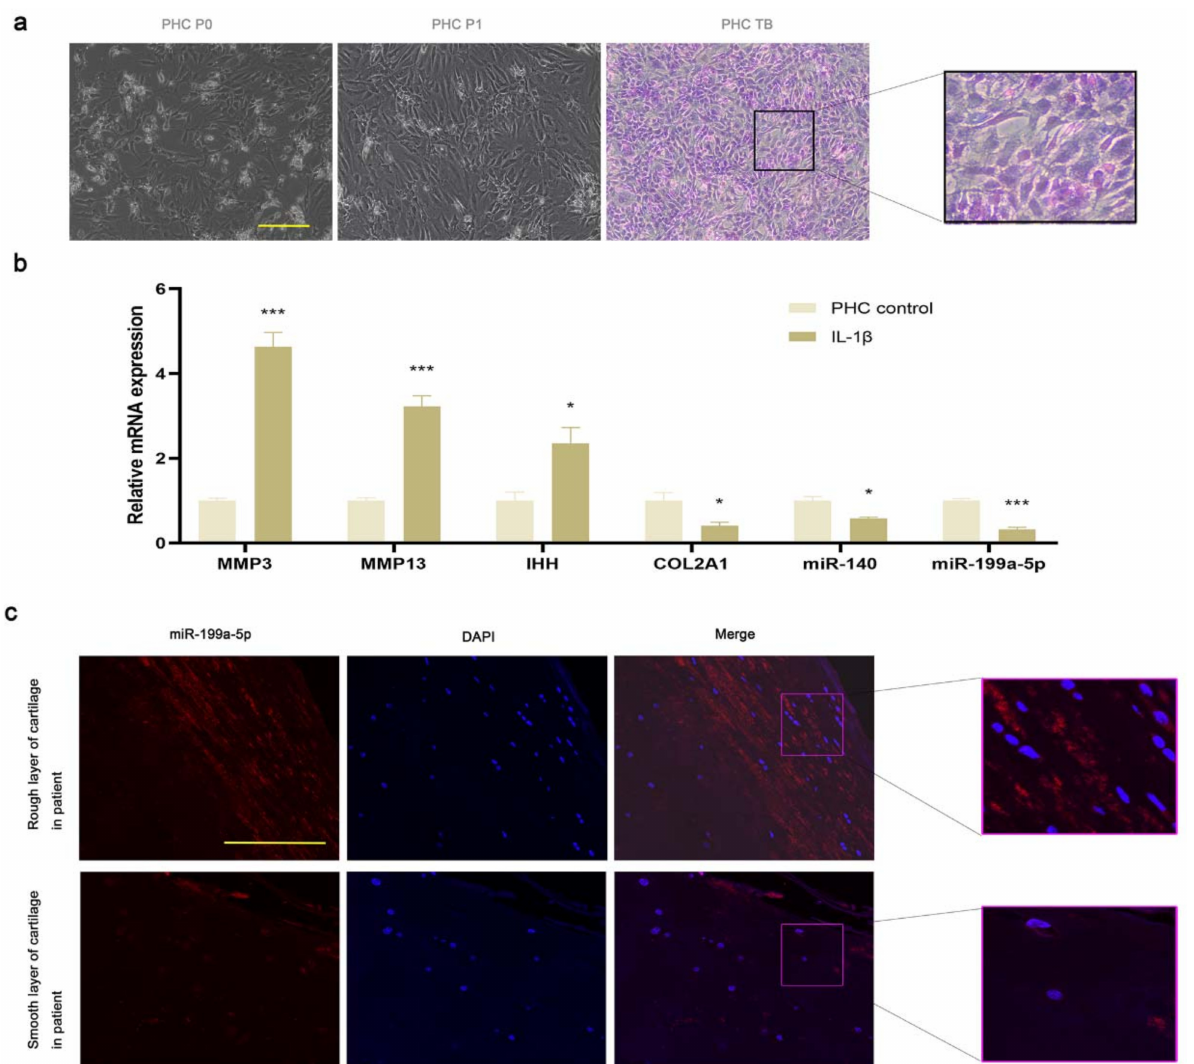
Figure 2. The expression of miR-199a-5p was reduced in OA PHCs and damaged cartilage tissues. ( a ) Light microscopy images of passage 0 and passage 1 PHCs, and toluidine blue staining for the passage 1 PHCs. ( b ) Relative mRNA and miRNA expression levels in chondrocytes. (* p < 0.05, *** p < 0.001; n =3 for each group). ( c ) FISH of miR-199a-5p in the smooth layer of articular carti- lage tissues compared with the rough layer of articular cartilage tissues in OA patients. Scale bar represents 100 µ